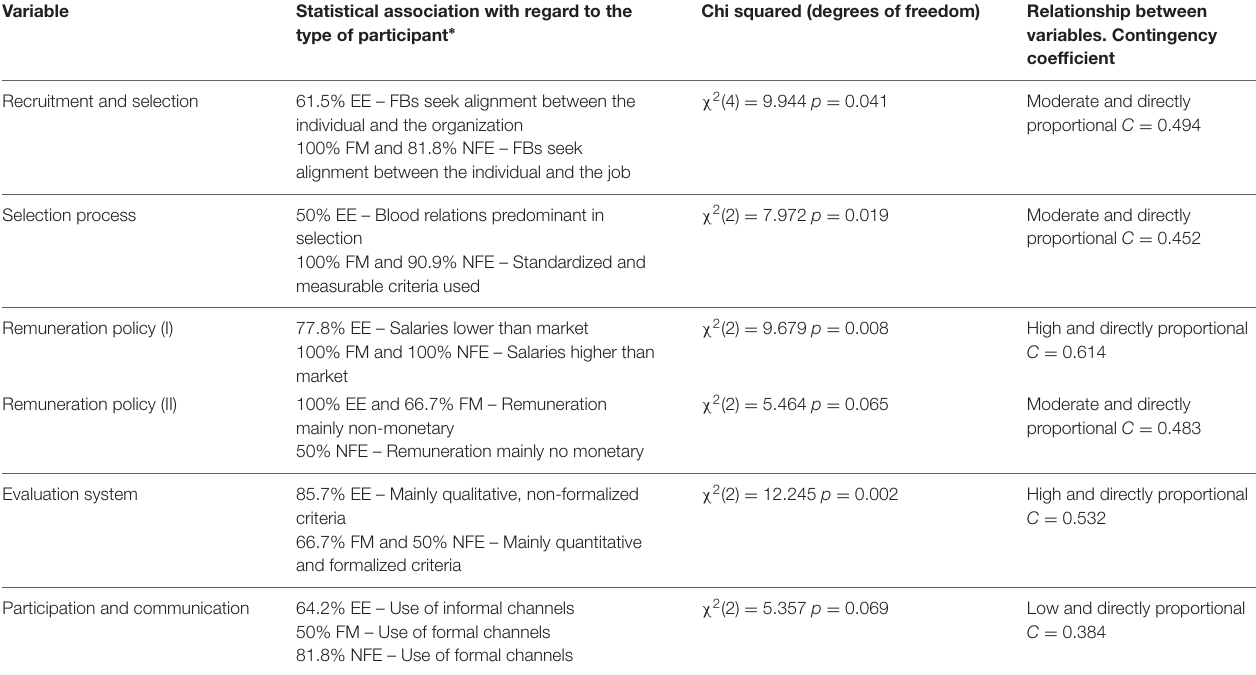
TABLE 2 | Association between variables of the study with regard to strategies and actions the improve IC satisfaction. Variable Statistical association with regard to the Chi squared (degrees of freedom) Relationship between type of participant ∗ variables.